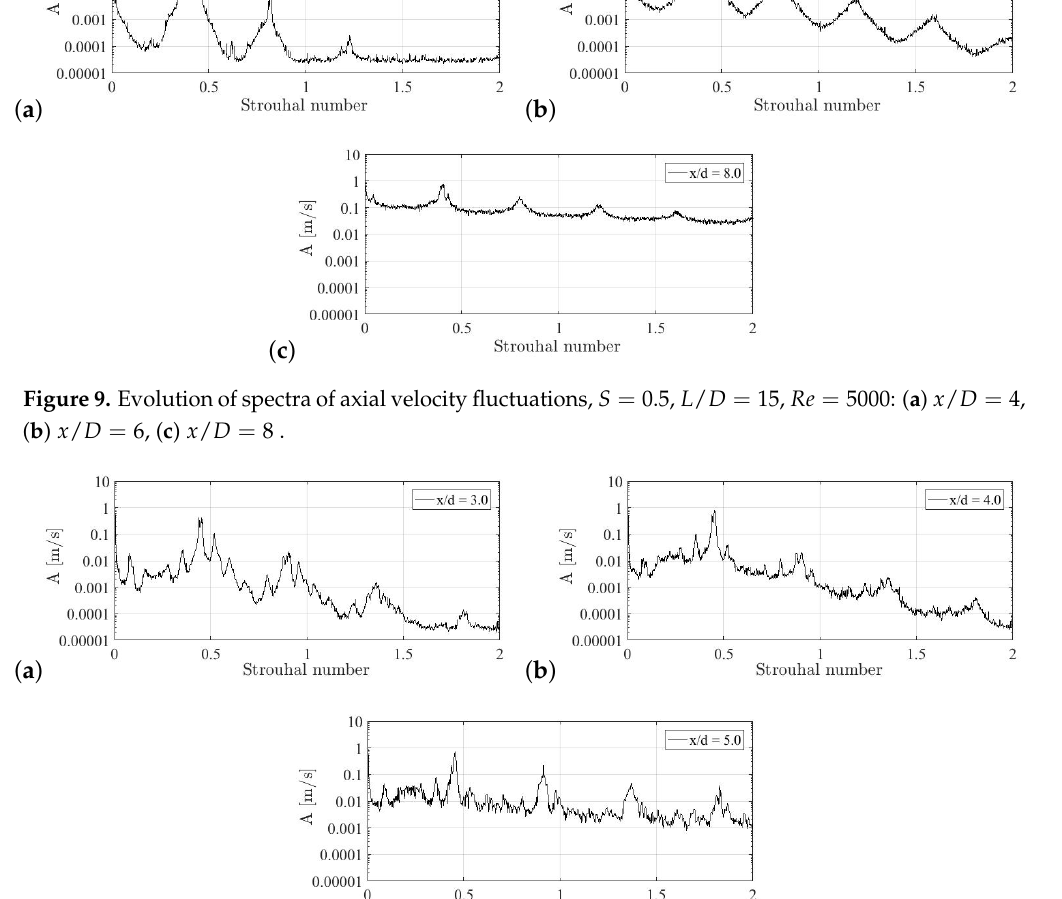
Figure 10. Evolution of spectra of axial velocity fluctuations, S = 0.5, L / D = 7, Re = 5000: ( a ) x / D = 3, ( b ) x / D = 4, ( c ) x / D = 5